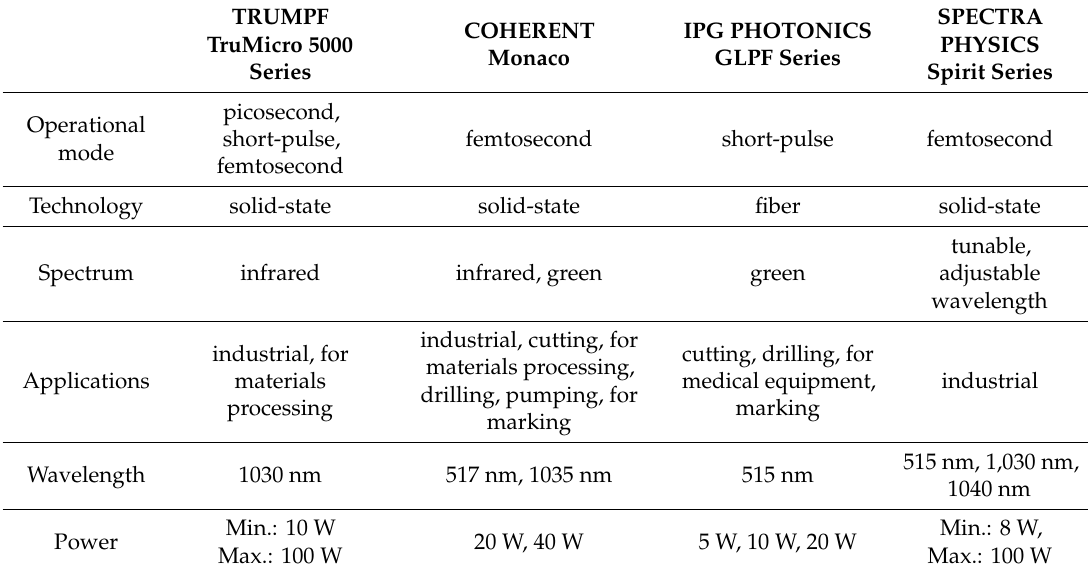
Table 1. A comparison of laser systems and parameters used for Si micromachining